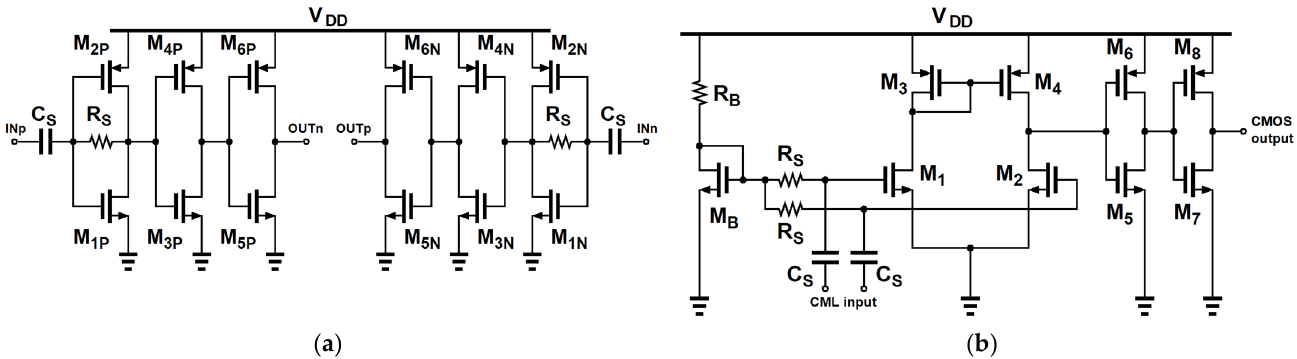
Figure 6. ( a ) Simplified schematic of 3 ‐ stage inverted ‐ based class ‐ AB amplifier; ( b ) simplified schematic of CML to CMOS converter.